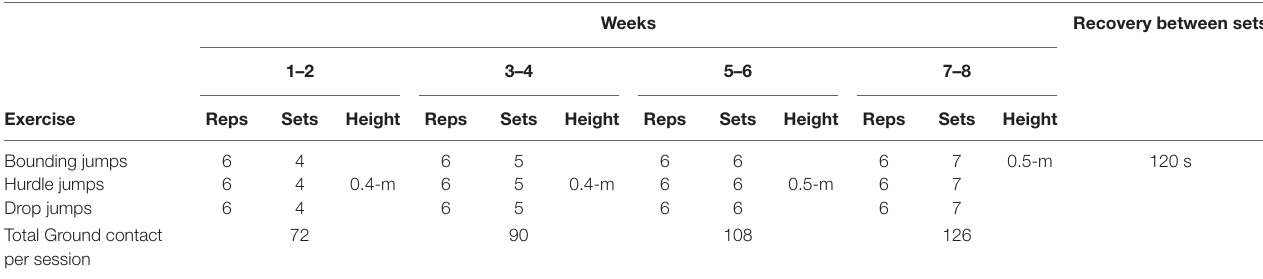
TABLE 3 | Plyometric training